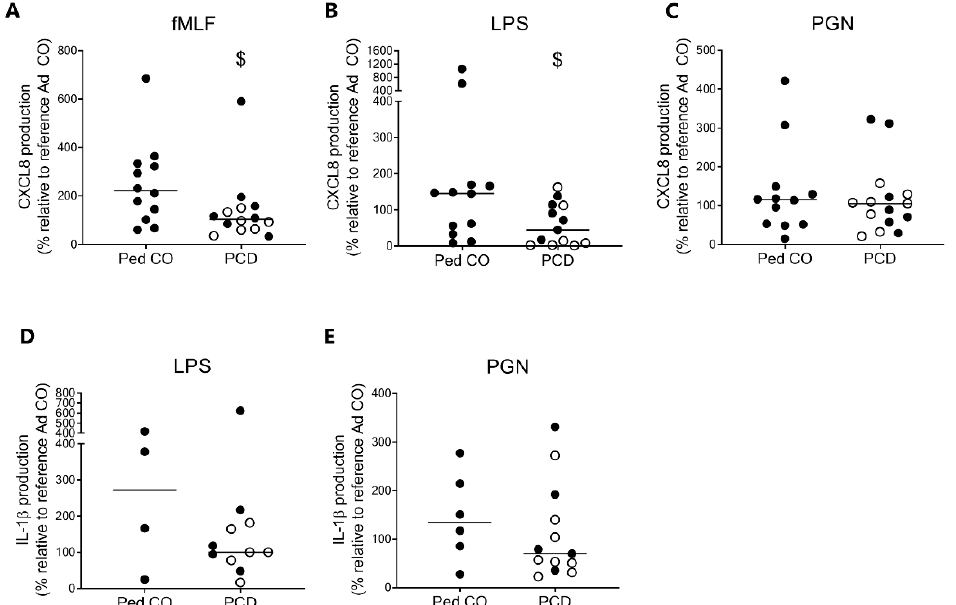
Figure 8. Peripheral blood PMNs from patients with PCD produce less CXCL8 upon stimulation with fMLF and LPS compared to PMNs from healthy controls. PMNs from patients with PCD (PCD, n = 11–15, 5-7 pediatric (indicated with dark circles) and 6-8 adult (open circles), age-matched healthy pediatric controls (Ped CO, n = 4–12) and healthy adult controls (Ad CO, n = 11–15) were supplemented with GM-CSF (20 ng/mL) and stimulated with (B,D) LPS (10 µ g/mL), ( C , E ) PGN (10 µ g/mL) or ( A ) fMLF (10 − 7 M) for 24 h at 37 ◦ C. ( A – C ) CXCL8 and ( D , E ) IL-1 β levels in the supernatants were measured with sandwich ELISA. The cytokine levels are expressed relative to the cytokine levels produced by the PMNs of the corresponding reference Ad CO (equal to 100%, not shown). Statistical differences were determined by Mann Whitney U-test ( $ p < 0.05).